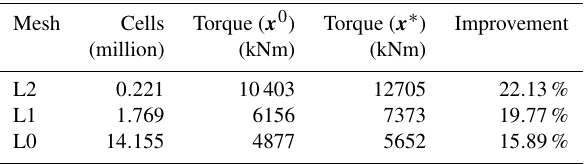
Table 8. Overview of single-point optimization results for the op- erational conditions of the 8ms − 1 case listed in Table